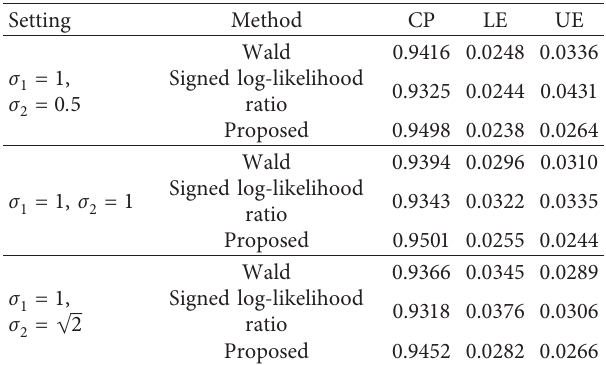
� 12, n � 12, and 1 2